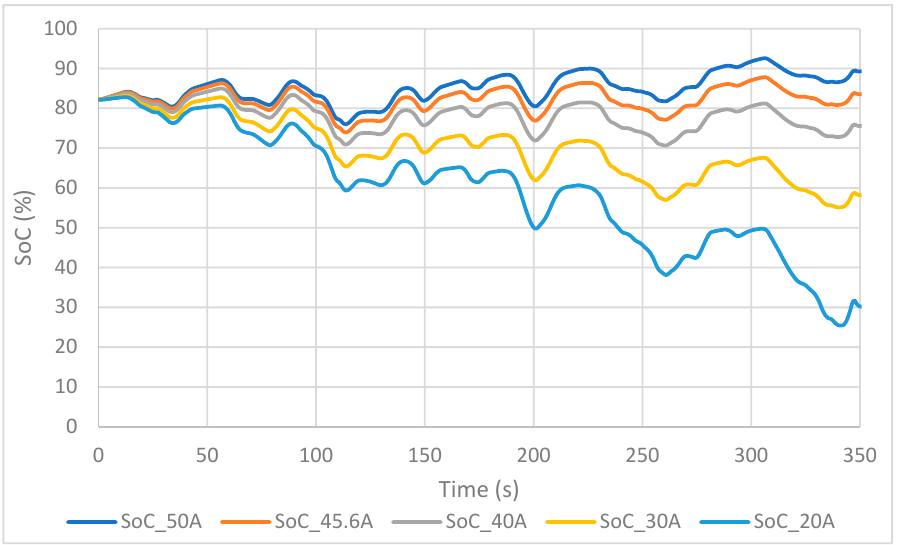
Figure 6. SoC change with reference variation of the peak power profile.